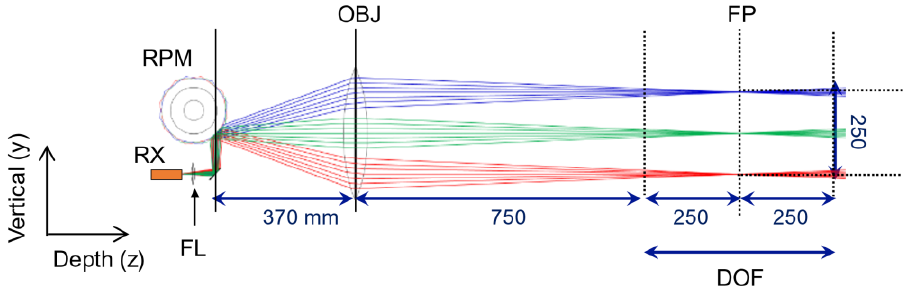
Figure 6. Ray of the scanning optical path.